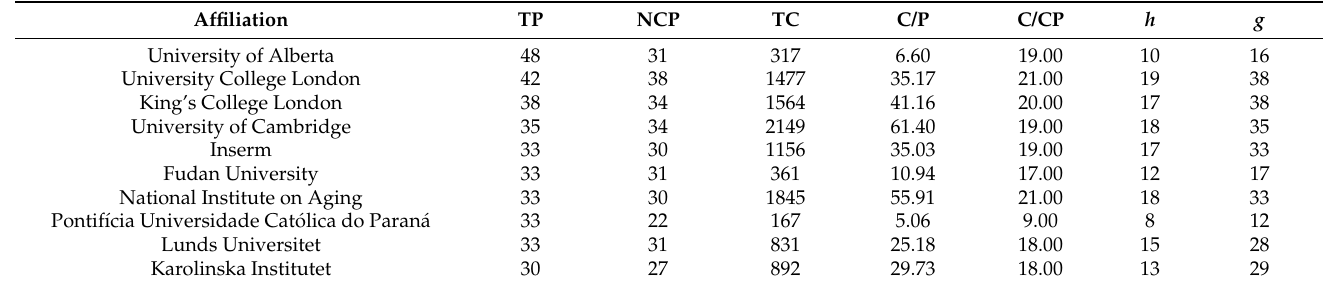
Table 3. Most influential institutions with a minimum of five publications.